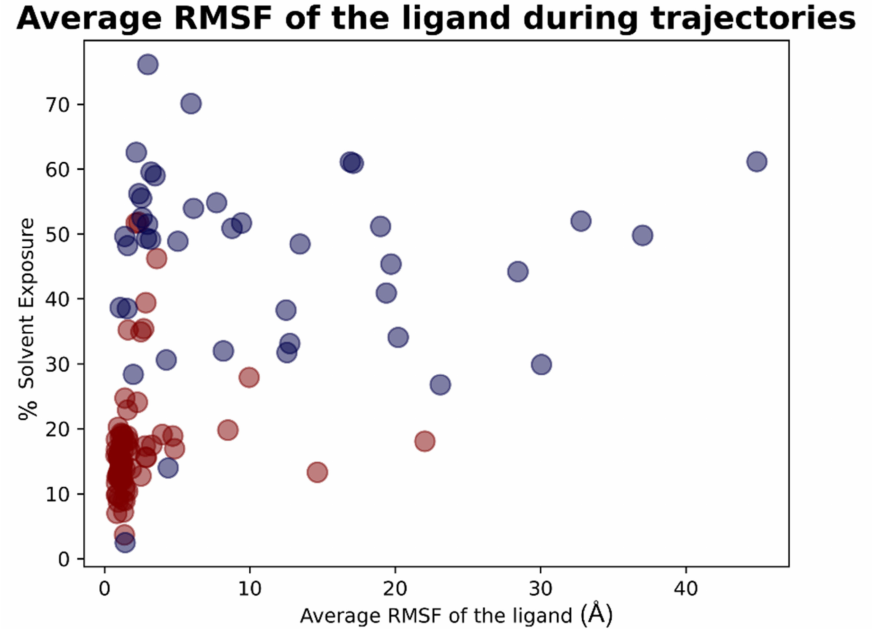
Figure 13. Scatter plots showing the different distribution of the mean RMSF values between the coordinates of the M pro ligands compared to crystallographic ones after the molecular dynamics simulations in respect to the solvent exposure of the corresponding crystallographic ligands. The red dots represent the ligands thatwere originally crystallized inside the catalytic pocket, while the blue dots represent the ligands crystallized in the other parts of M pro . As can be noticed, the molecules showing the best values of RMSF after the analysis of the trajectories are mainly located inside the catalytic pocket and characterized by a low solvent exposure of the original crystallographic